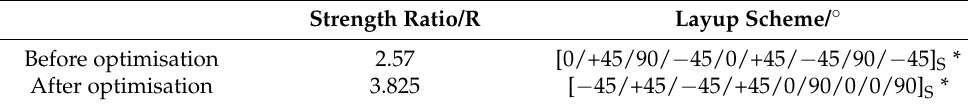
Table 4. Comparison before and after layup optimisation.